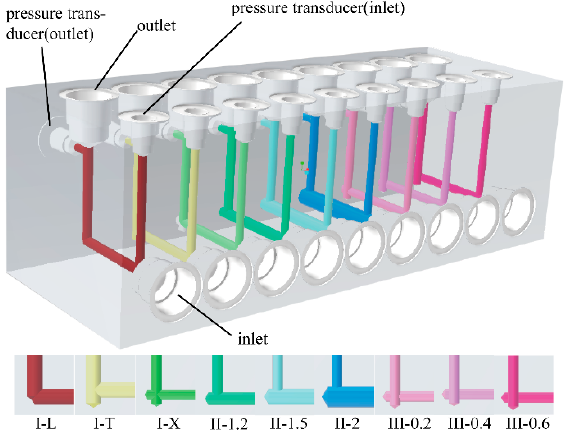
Figure 2. A manifold sample containing nine single passages.